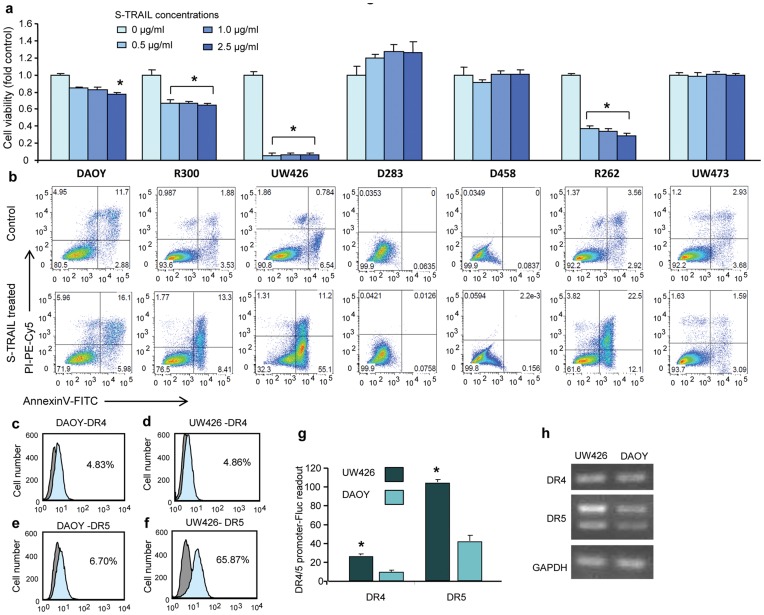
TRAIL sensitivity or resistance in MBs is correlated with DR4 and DR5 levels cells.(a) Plot showing the cell viability analysis on different MB cell lines treated with S-TRAIL. (b) FACS scatter plots showing Annexin V and PI staining on MB cell lines after treatment with 0 or 100 ng/mL S-TRAIL. (c–f) FACS histogram plots showing endogenous levels of DR4 (c–d) and DR5 (e–f) on DAOY (TRAIL-resistant) and UW426 (TRAIL-sensitive) cells (grey peak = isotype control). (g) Plot showing the levels of DR4 and DR5 in DAOY and UW426 cells transduced with LV-pDR4-Fluc and LV-pDR5-Fluc. (h) RT-PCR analysis showing endogenous levels of DR4 and DR5 mRNA expression in DAOY and UW426 cells. GAPDH is used as control. * denotes p<0.05 in the comparison of each treatment to controls, student’s t-test.